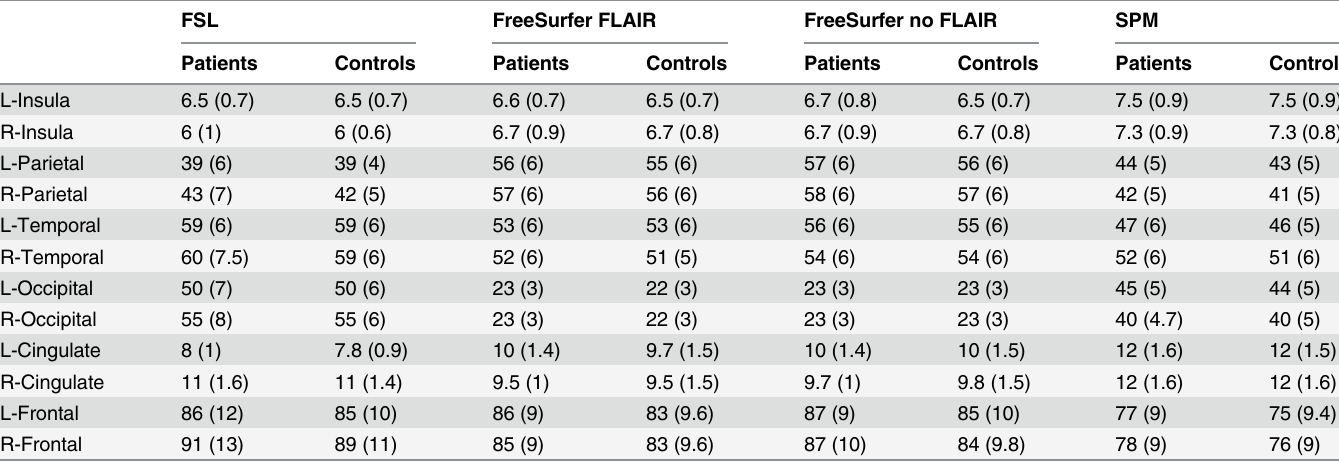
Table 2. Lobar GM volumes (mL) with all software